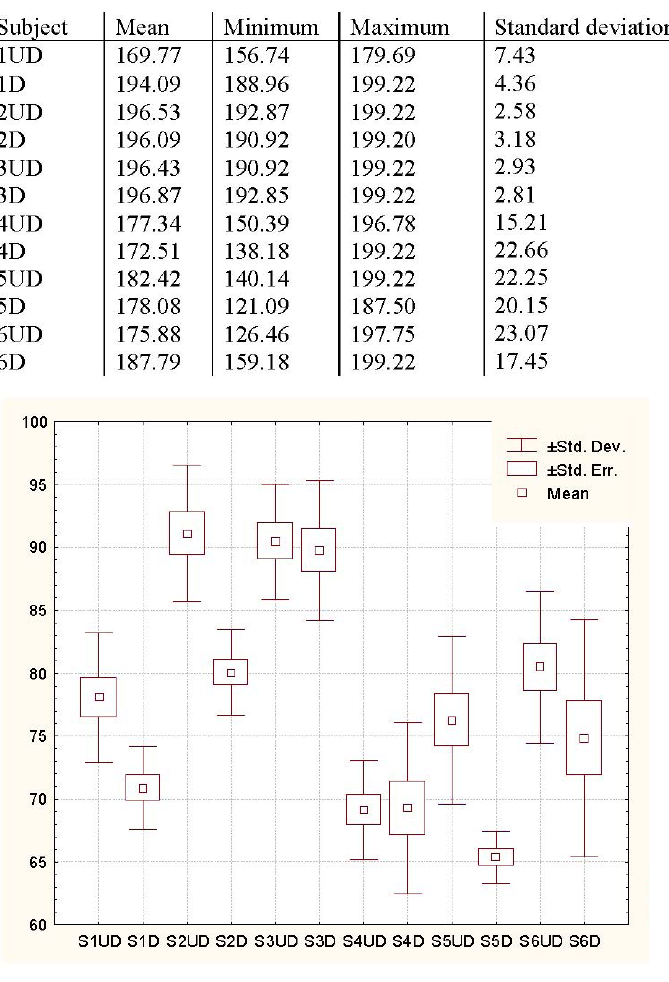
implicit times measured 1